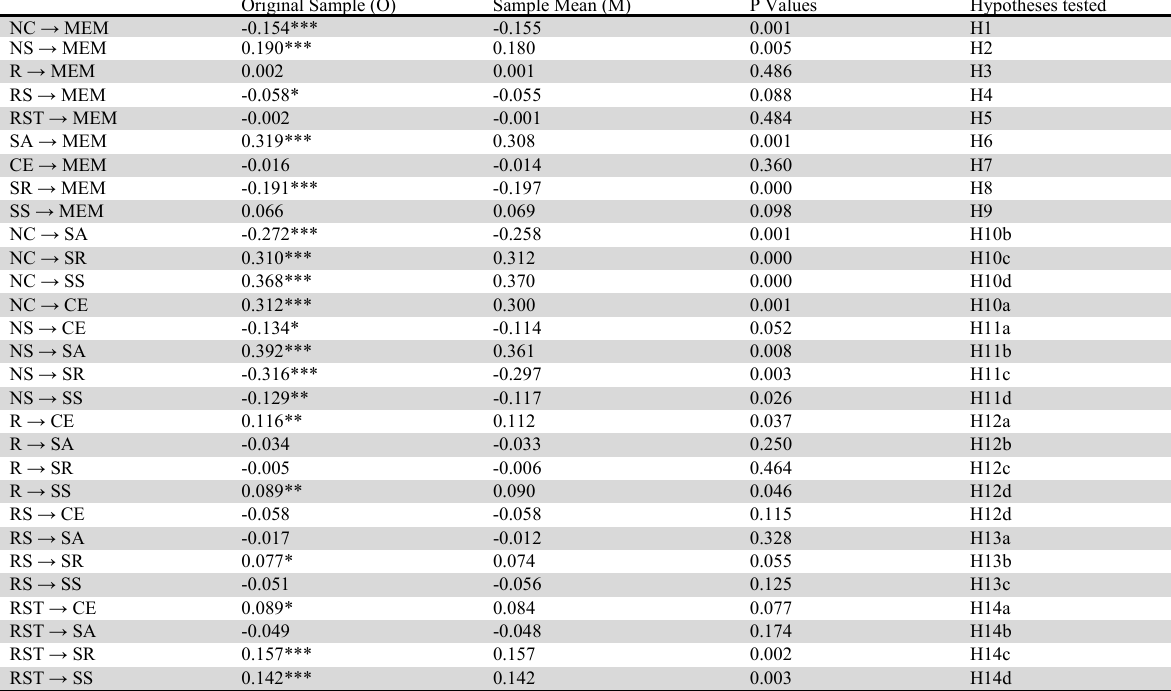
Significant testing results of the structural model path coefficients